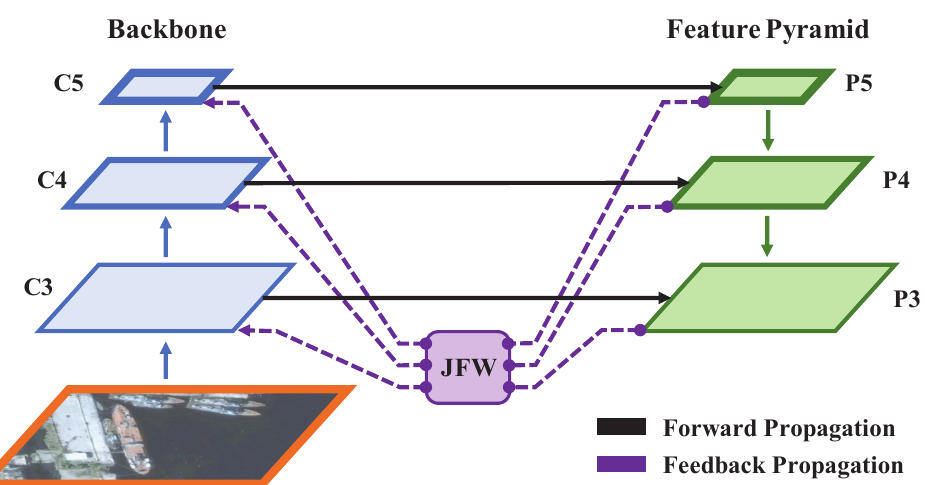
Figure 4. In the schema of JRFP, C3, C4, and C5 denote the output features of stages in the backbone network, respectively, and P3, P4, and P5 denote the features in pyramid levels,